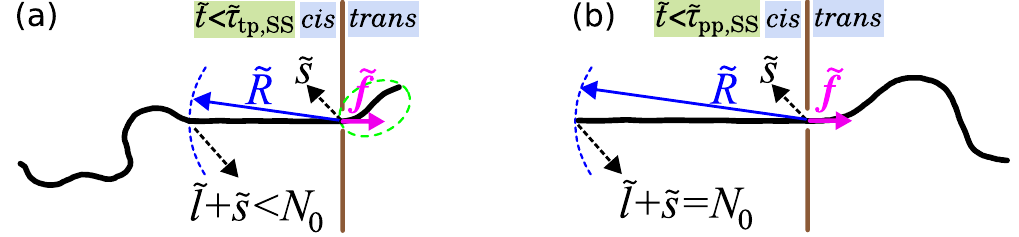
Figure 1. ( a ) A schematic of the translocation process in the tension propagation (TP) stage, i.e. < ˜ ˜ t t the strong stretching (SS) regime. N 0 is the contour length of polymer and the translocation coordinate  s equals the number of beads that have already been translocated into the trans side. The number of beads influenced by the tension force is +  ˜ l s , which during TP stage is less than N 0 .  R determines the location of the tension front.